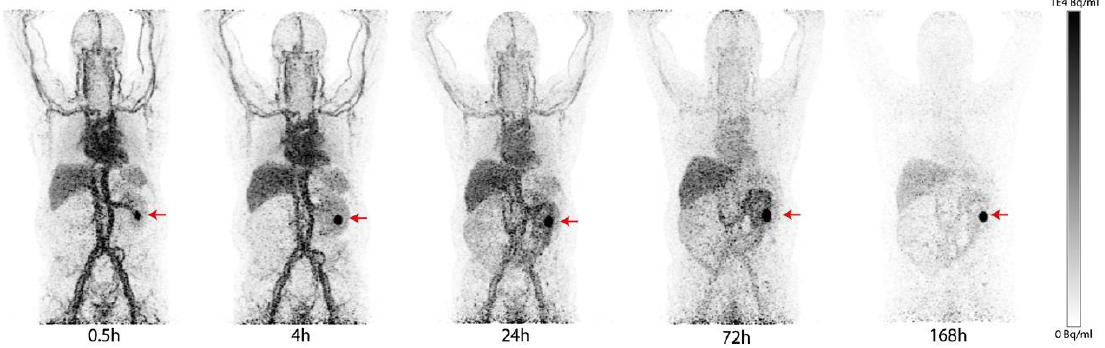
Figure 1. PET/CT imaging of a patient with a ccRCC tumor in the left kidney (red arrow) after in- jection of [ 89 Zr]Zr -girentuximab . The patient received a mass dose of 10 mg of girentuximab